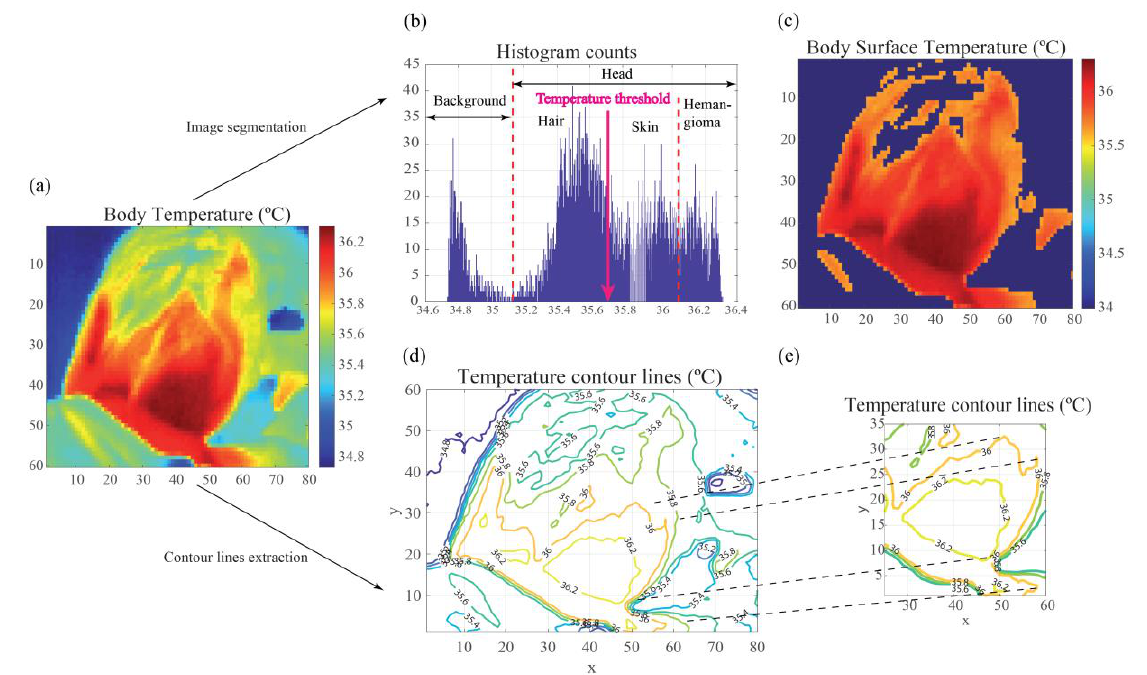
Figure 6. Illustration of the processing steps involved in image segmentation. ( a ) Original thermo- graphic image with absolute temperature values. ( b ) Histogram of the original thermographic im- age. The temperature threshold, TH , determined by Otsu’s algorithm for segmenting skin, is high- lighted. ( c ) Segmented image displaying only the temperature values of the patient’s skin. ( d ) Tem- perature contour lines extracted from the original image. The contour lines with the highest tem- perature correspond to the IH’s location. ( e ) Detail of the temperature contour lines in the region affected by the malformation. The area inside a temperature contour line can be computed using the coordinate method.